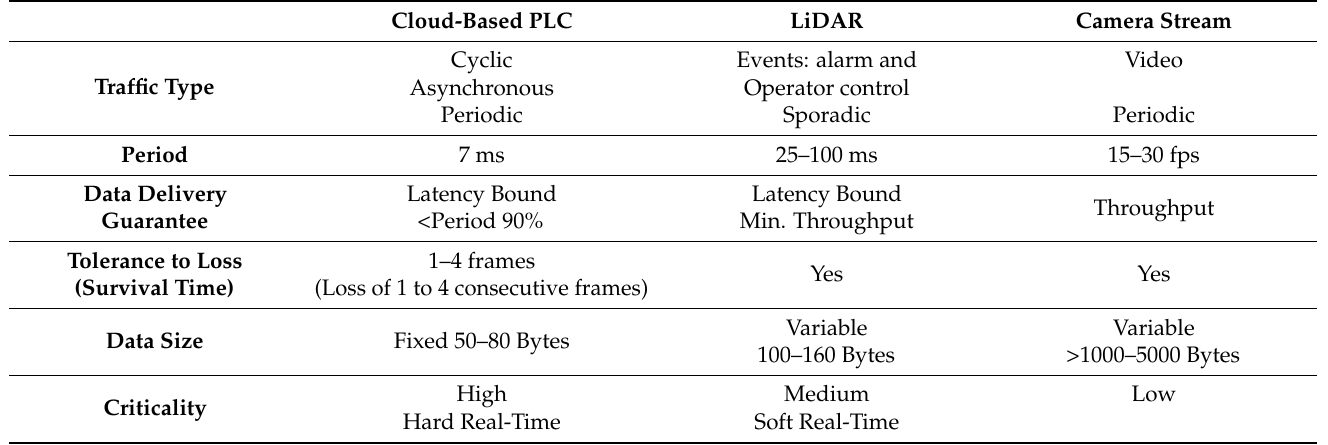
Table 1. Traffic characteristics for the mobile robotics use case. Cloud-Based PLC LiDAR Camera